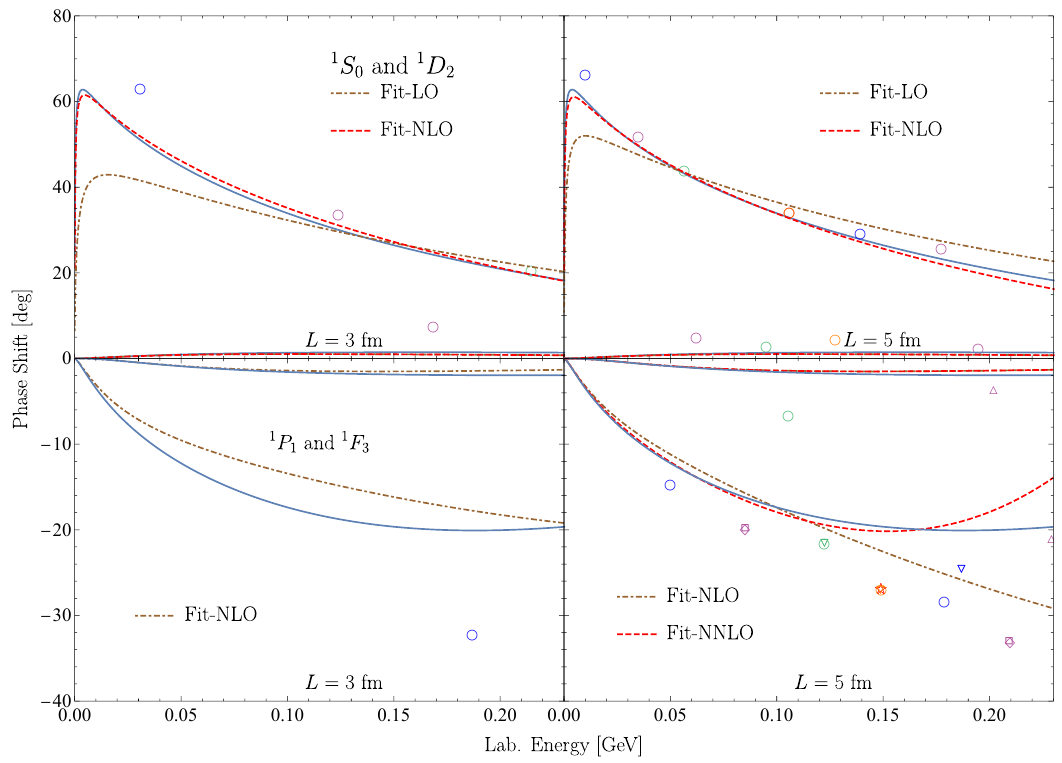
Figure 10 . 1 S 0 (upper row) and 1 P 1 (lower row) phase shifts extracted by matching the EFT to the finite-volume spectra for the toy-model example in comparison with the underlying phase shifts shown by the solid blue lines. Brown dashed-dotted (red dashed) lines show the results from single-parameter (two-parameter) fits to the FV energies as visualized in figures 8 and 9. Left and right panels correspond to the boxes of the size L = 3 fm and L = 5 fm, respectively. Also shown by various symbols are the phase shifts extracted from the FV energies using the single-channel Lüscher formula. The lines near δ l ∼ 0 show the phase shifts in the next-higher partial wave for a given parity quantum number (i.e. in the 1 D 2 and 1 F 3 channels in the upper and lower row, respectively). For remaining notations see figure